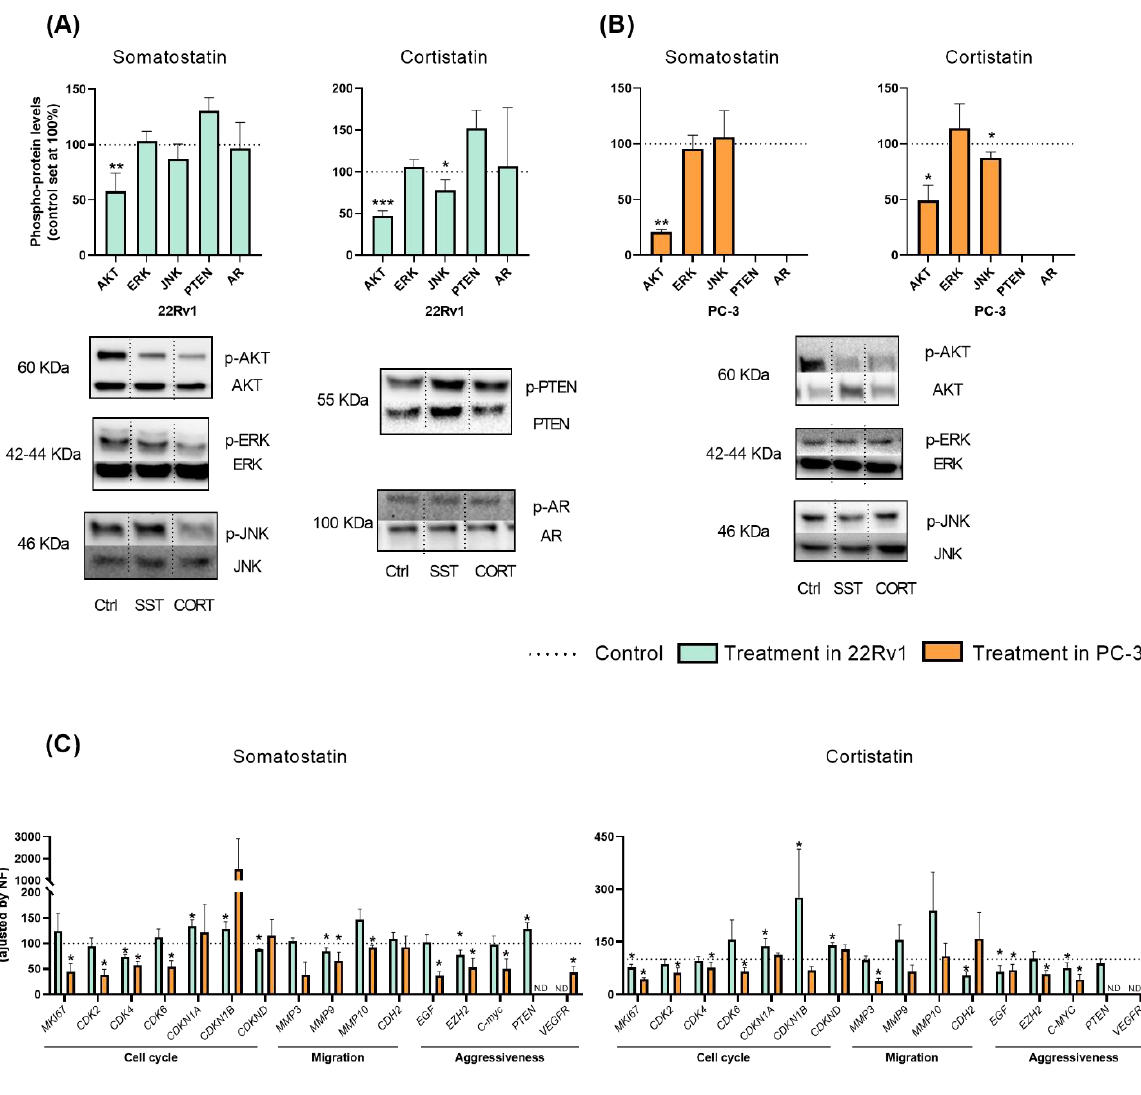
Figure 2. Molecular consequences of somatostatin (SST) or cortistatin (CORT) treatment in androgen-independent (AI) prostate cancer (PCa) cells. ( A , B ) Phosphorylation levels of protein belonging to different oncogenic signaling pathways (AKT, ERK, JNK, PTEN and AR) in response to SST and CORT treatment in AI-PCa cells. Phospho-protein levels were normalized by the total amount of each respective protein. Protein data were represented as percent of vehicle-treated cells (set at 100%). ( C ) Fold change in markers of proliferation, migration, and PCa-aggressiveness in response to SST and CORT treatment in AI-PCa cells. Gene expression was represented as the percentage of vehicle-treated cells (set at 100%). Asterisks (* p < 0.05; ** p < 0.01 and *** p < 0.001) indicate statistically significant differences between treatment and vehicle-treated cells. N.D: Non-detected. Ctrl: Control.